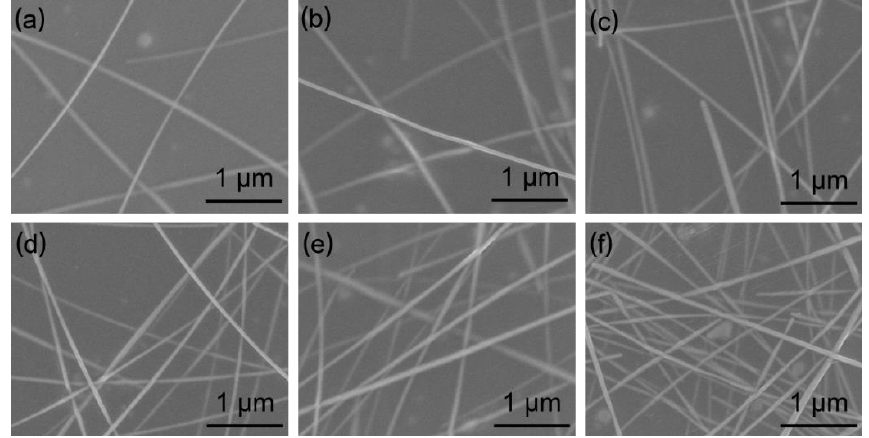
Figure 5. SEM morphology of AgNW TCFs prepared at different AgNW concentrations: ( a ) 0.5, ( b ) 0.8, ( c ) 1.1, ( d ) 1.3, ( e ) 1.6, and ( f ) 1.9 mg·mL −1 .